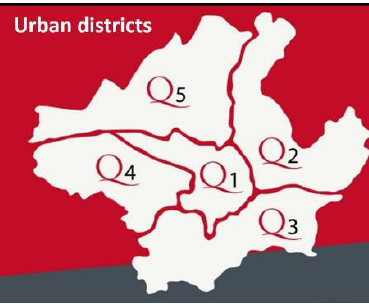
Animals 2021 , 11 , 1685 Figure 1. The distribution of the urban districts in Florence city. Figure 1. The distribution of the urban districts in Florence city.